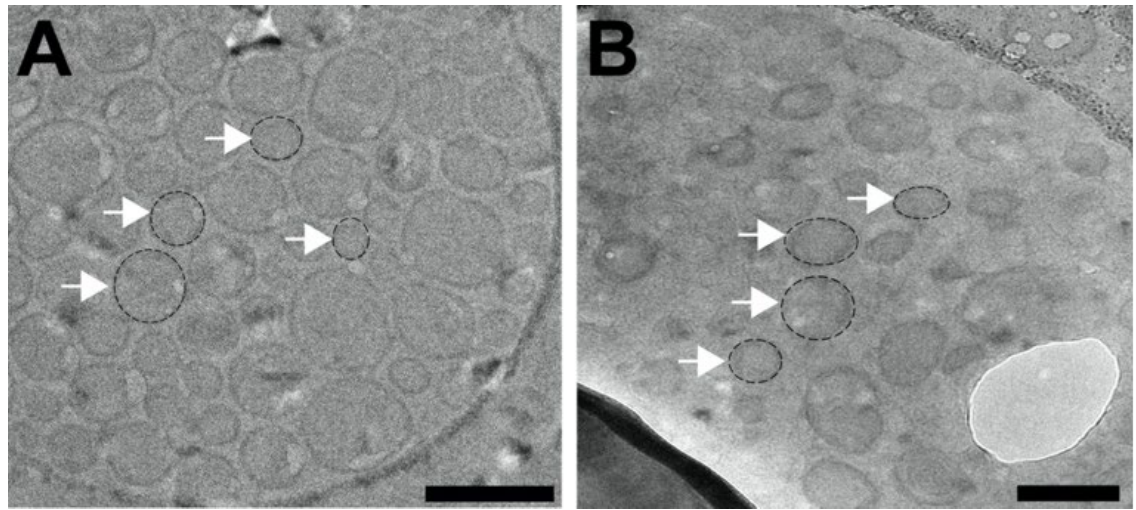
Figure 1. Cryogenic Transmission Electron Micrographs (Cryo-EM) of ( A ) liposomes without chloroquine, and ( B ) liposomes encapsulating chloroquine. Black dashed outlines and white arrows highlighted some liposomes as a guide to the eye. Scale bars: 200 nm.